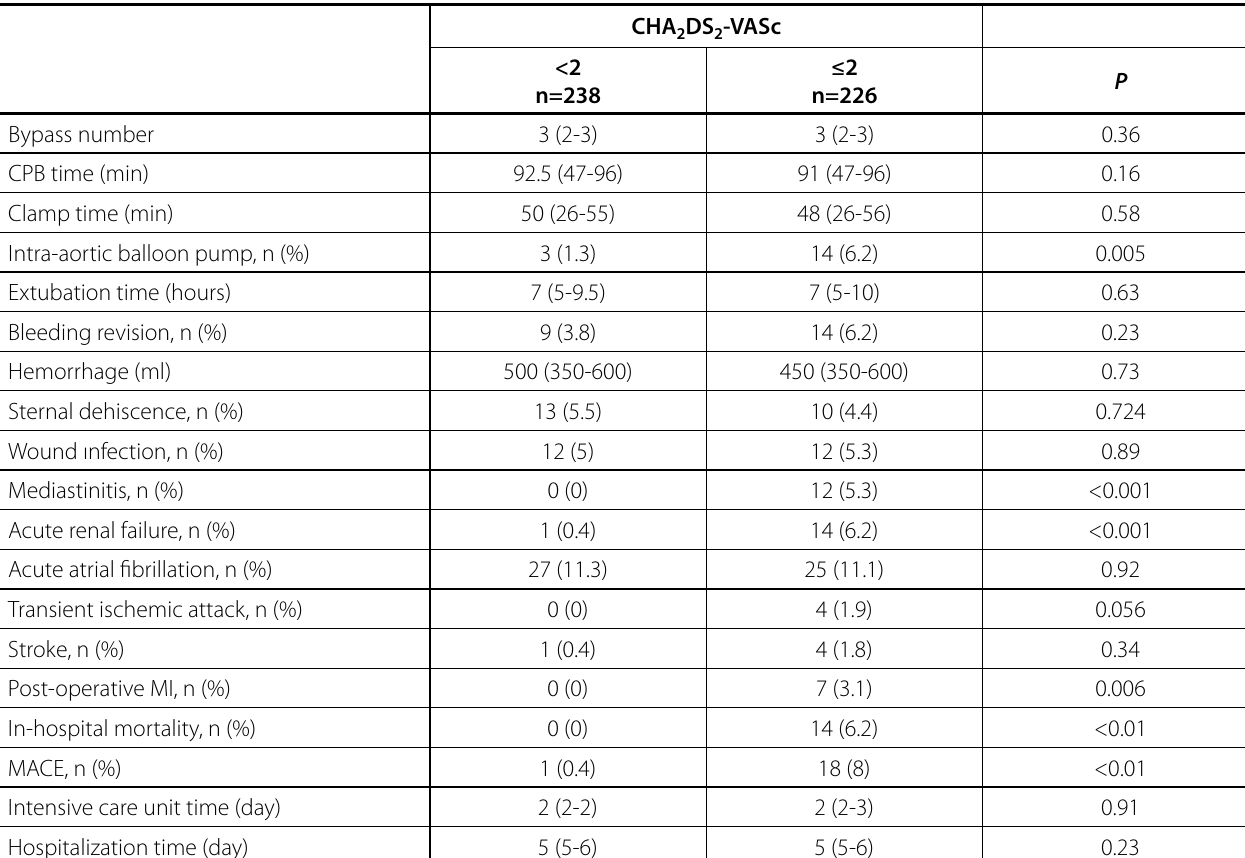
Table 2 . Operative and postoperative parameters of the groups.